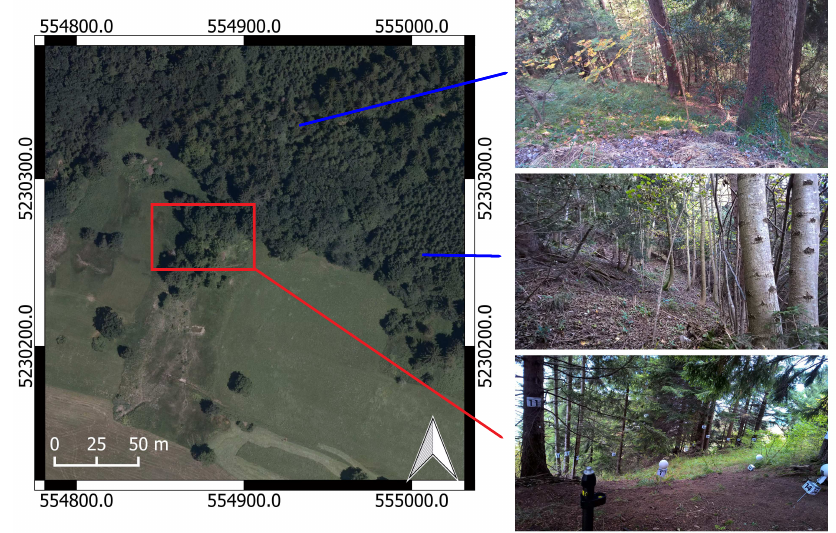
Figure 1. Landslide-affected forest in the Austrian Alps. Trees are inclined after shallow landslide caused soil movements. The red rectangle covers the area in this study. Coordinates in WGS84 UTM Zone